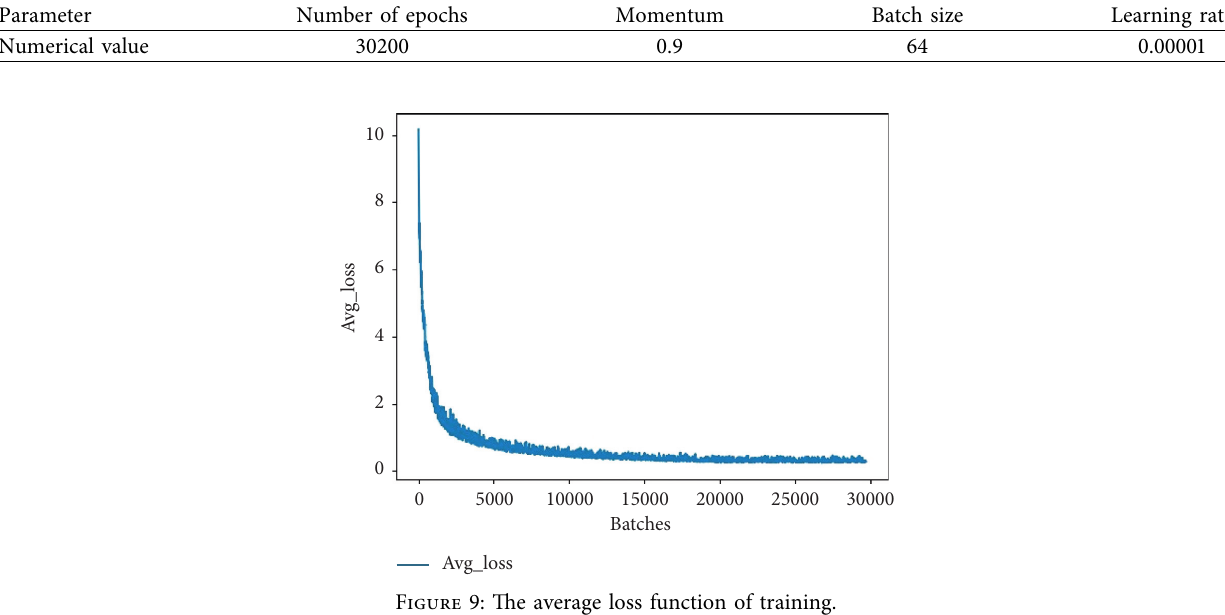
Figure 8: Example of the comparison of sample images of grass carp dataset before and after restoration: (a) NL; (b) NOL; (c) NORL. Table 3: Hyperparameters to train.